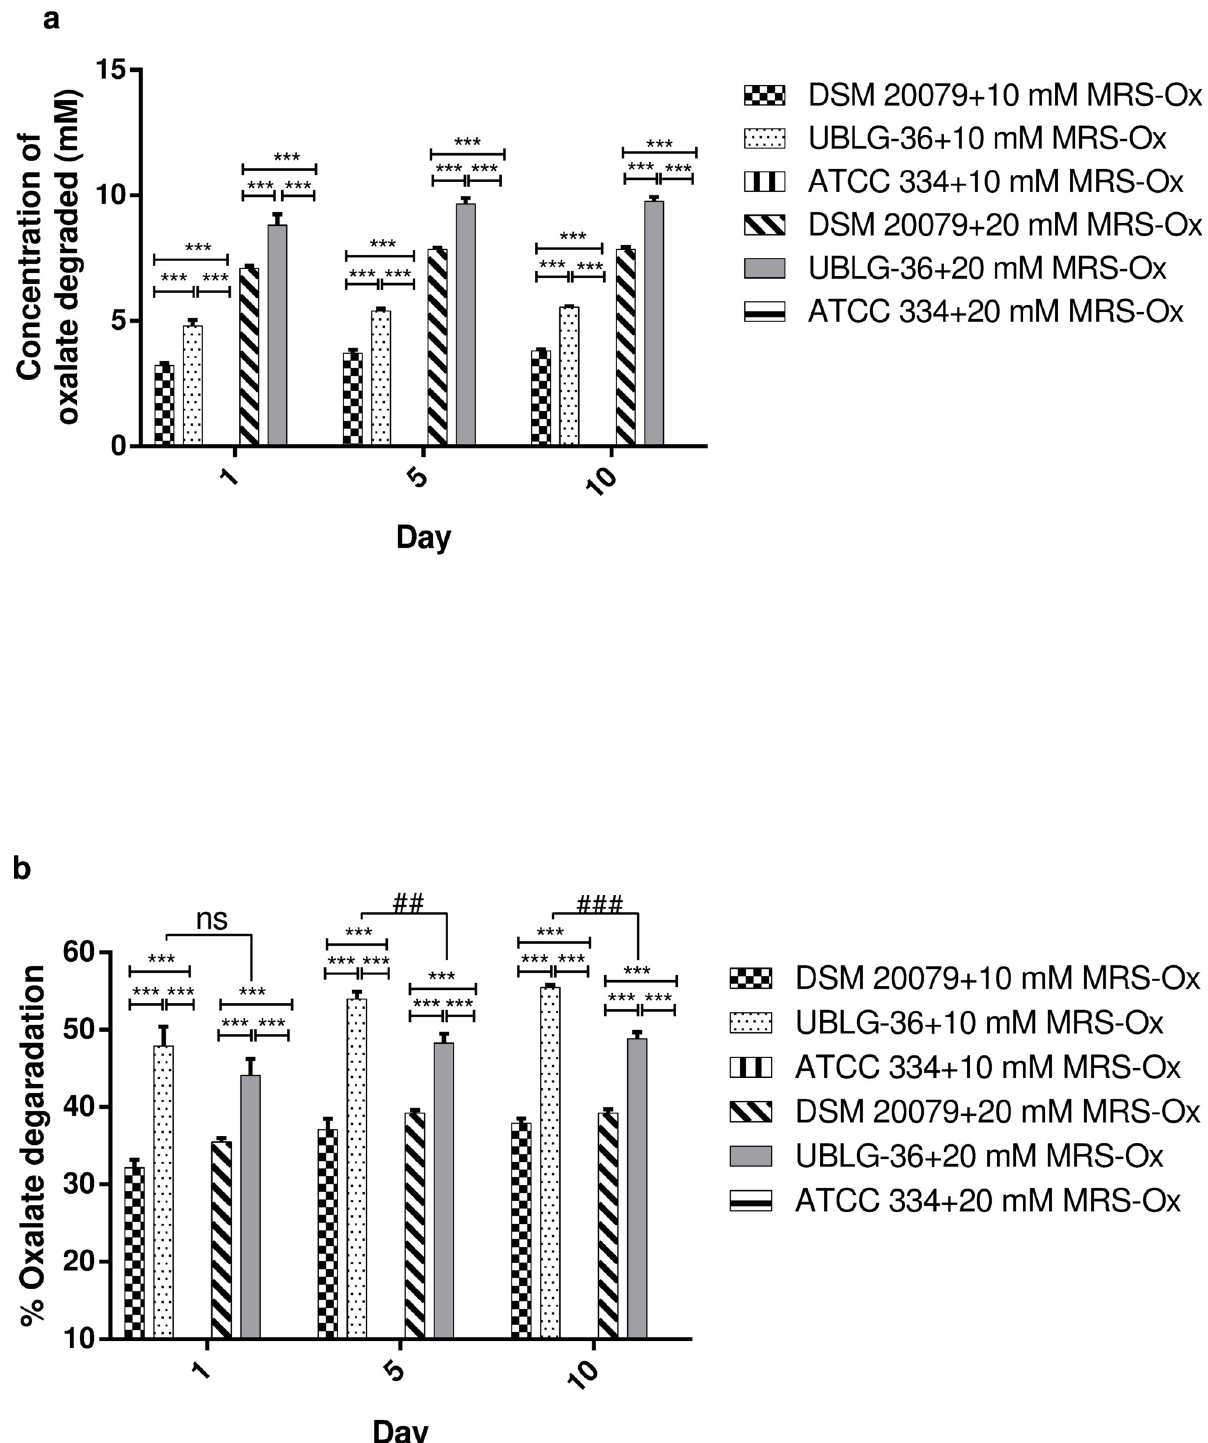
Fig 3. Evaluation of in vitro oxalate degradation. (a) The concentration of oxalate degraded by Lactobacillus paragasseri UBLG-36 and (b) percent oxalate degradation by Lactobacillus paragasseri UBLG-36 when incubated for 1, 5, and 10 days in 10 mM and 20 mM MRS-Ox. L . acidophilus DSM 20079 served as the positive control whereas, L . Casei ATCC 334 served as the negative control. L . Casei ATCC 334 showed no oxalate degradation. Data are presented as mean ± SEM from three experimental replicates. ��� p < 0 . 001 , ### p < 0.001, and ## p < 0 . 01 denotes statistical significance. ns denotes